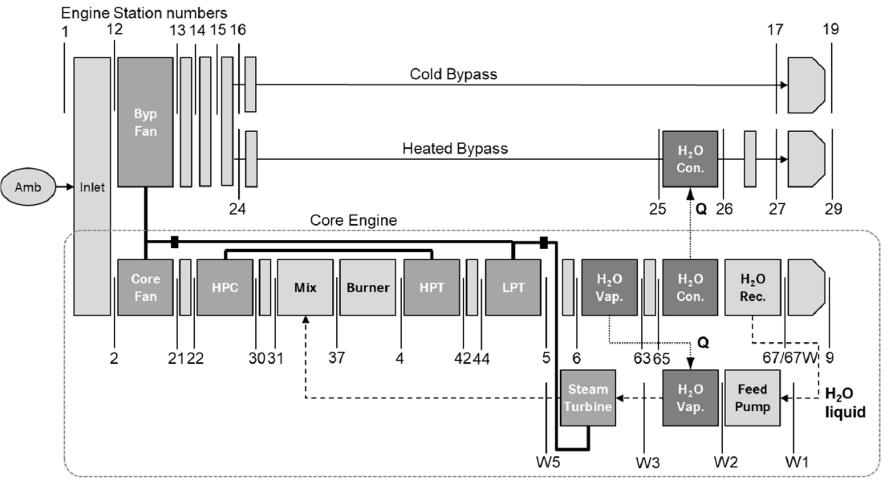
Figure 4. Simplified schematic of WET configuration as implemented in NPSS with station nomenclature.